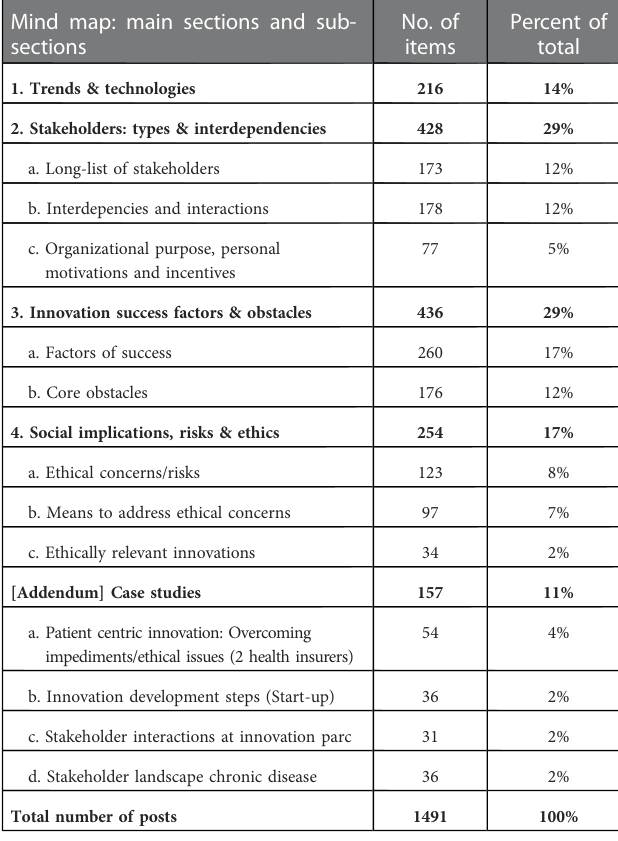
TABLE 1 Map item break-down: break-down of the posts made by participants according to each of the six sections on the mind map. Mind map: main sections and sub- sections